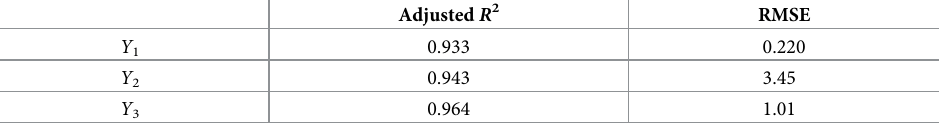
Table 7. Adjusted R 2 and RMSE values for Model C-Outdoor. Y 1 , Y 2 , and Y 3 are Δ E , Δ Gloss 60 , and Δ Haze ,